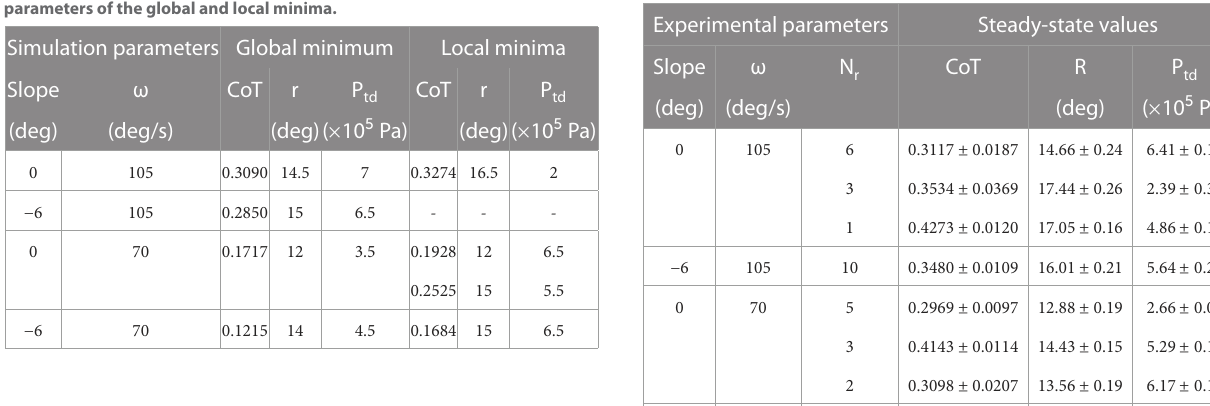
TABLE5 Experimentalsetupsandsteady-statestatistics.